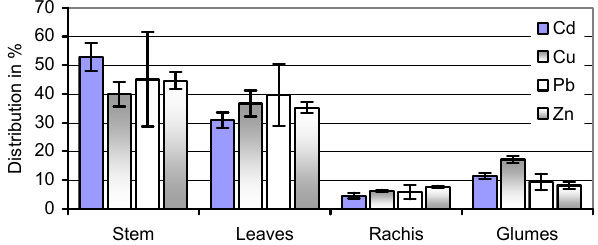
Figure 4. Approximate distribution (%) of Cd, Cu, Pb, and Zn in straw sections of wheat cv. JB Asano grown on the metalliferous gradient soil A. Error bars show ± SD.